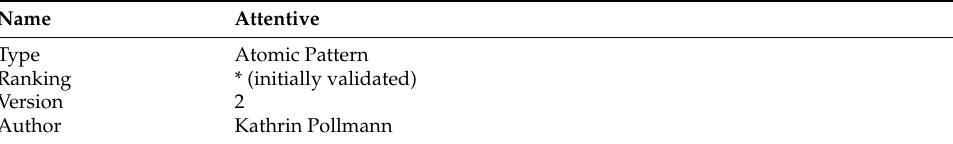
Table A3. Formal documentation of the pattern for the robot action “direct attention to